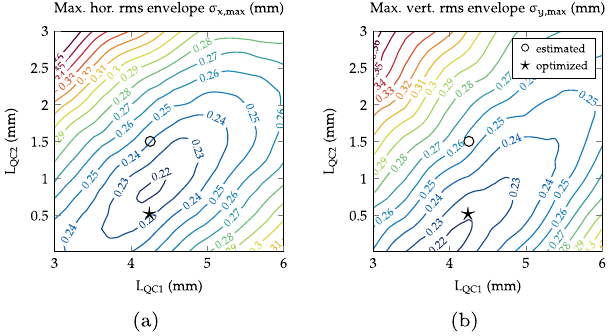
and σ (b) as functions of the lengths of the quadrupole cells y; max L and L . The numerically determined optimum parameters QC 1 QC 2 ( ⋆ ) shows good agreement with the analytic estimate ( ∘ ) obtained from Eqs. (14) and (15).